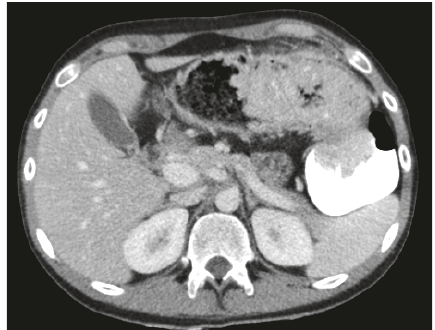
Figure4:AbdominalCTscanshowingobstructiveGIPofthesplen- ic flexure.